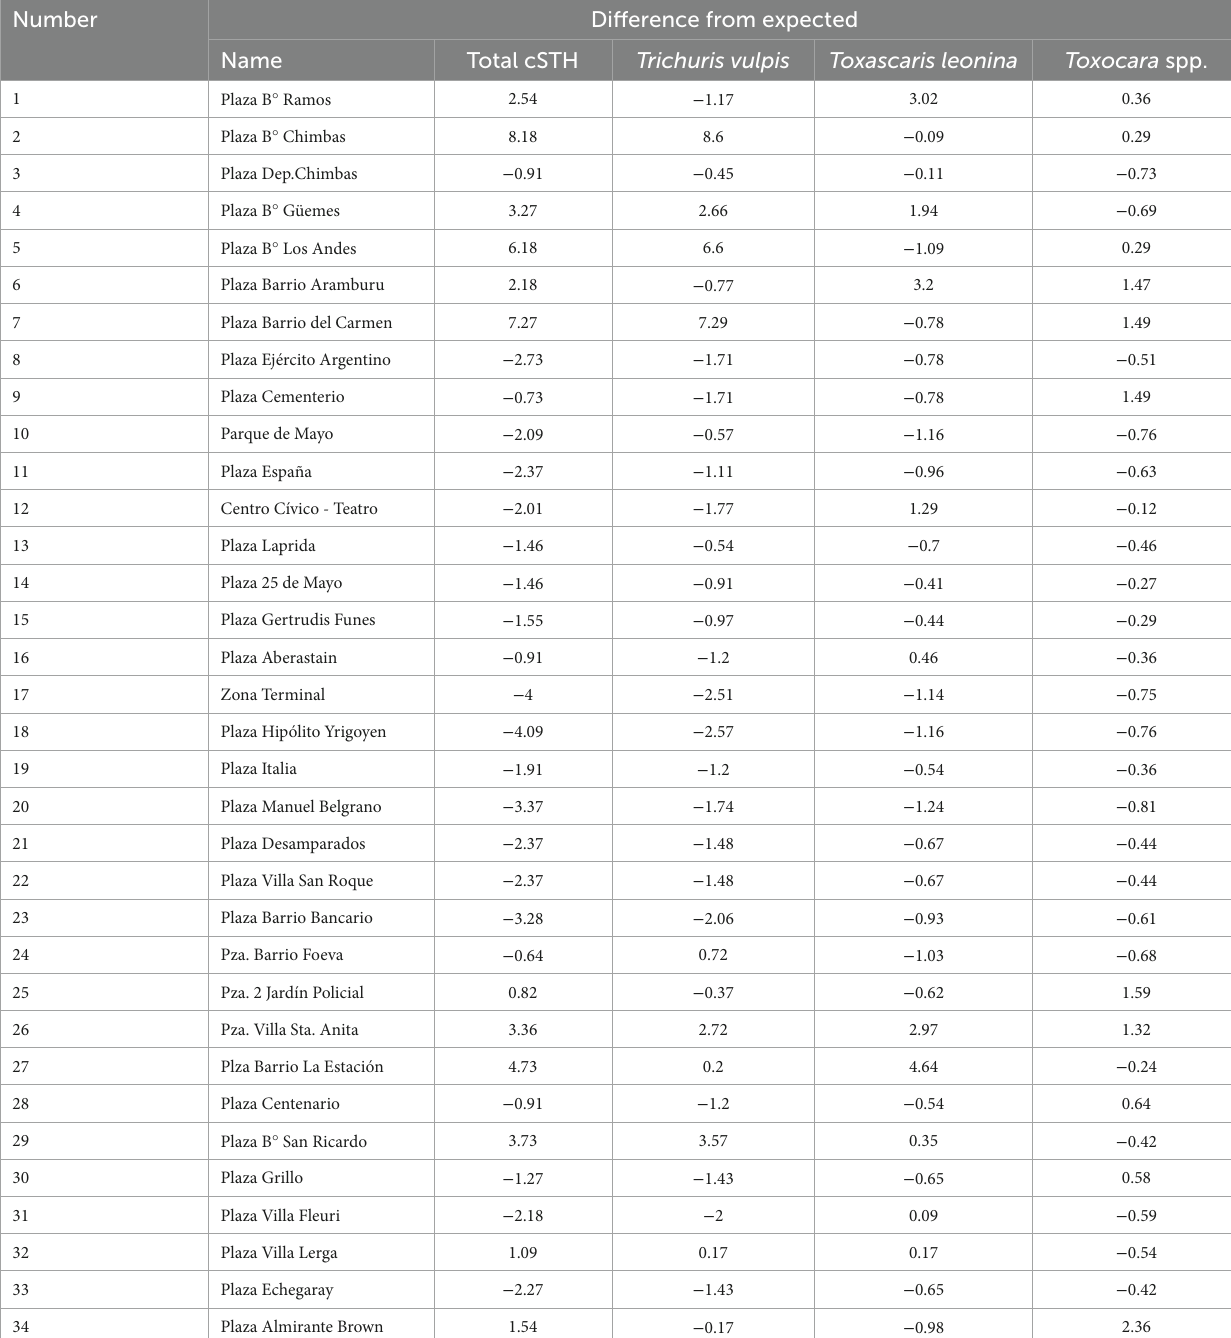
TABLE 2 The difference between observed and expected values, assuming a homogeneous distribution, of positive cases of canine soil-transmitted helminths (cSTHs) in canine environmental feces collected from different squares and parks from San Juan City (San Juan Province, Argentina). Number Difference from expected Name Total cSTH Trichuris vulpis Toxocara spp.